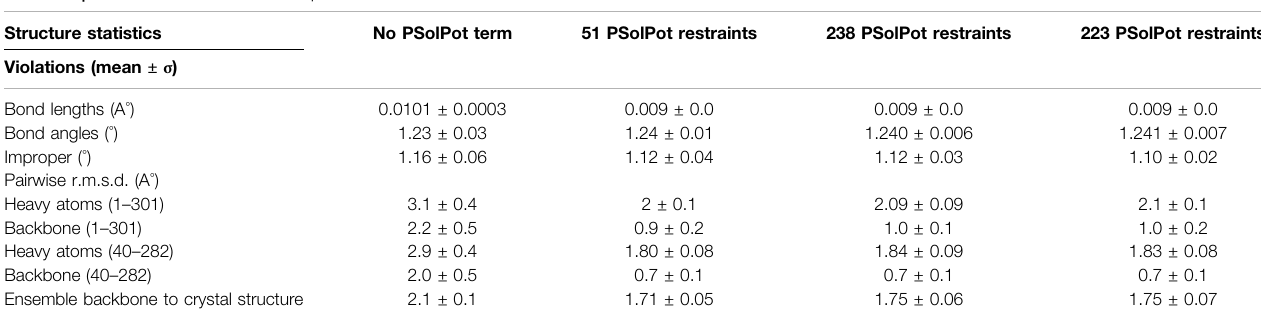
TABLE 2 | Structural statistics for IMMx